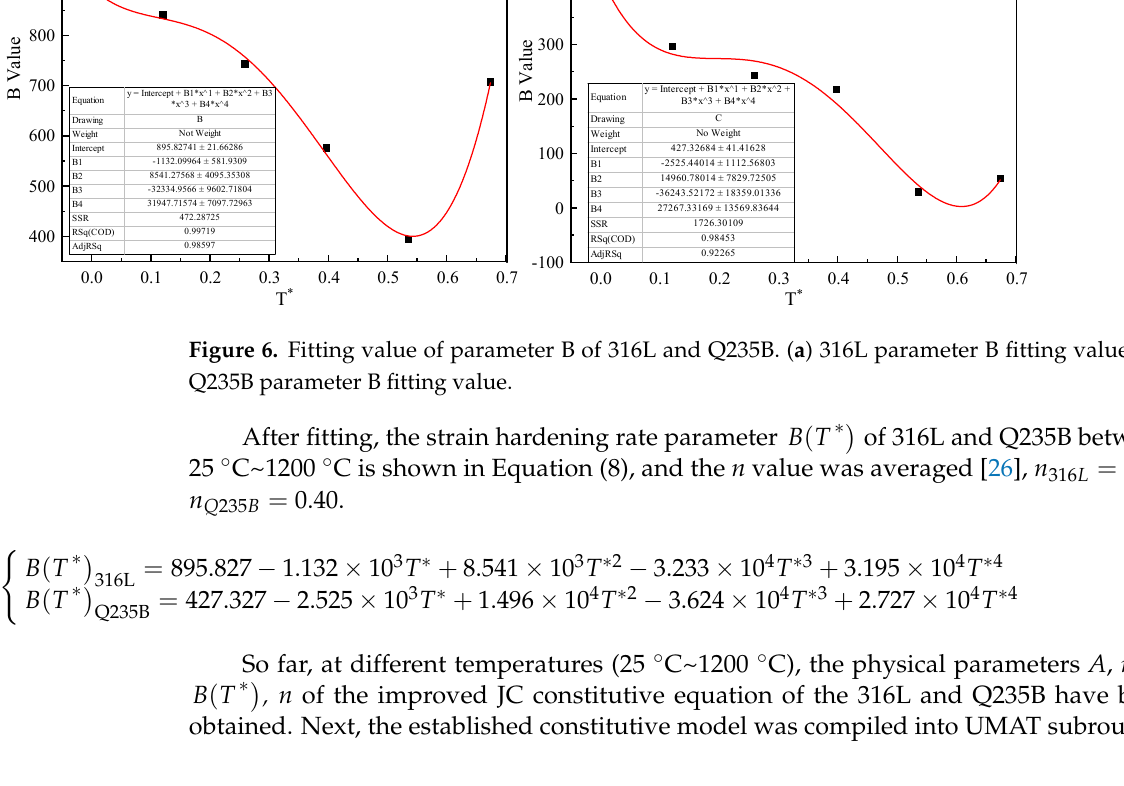
temperature. ( b ) Change of n parameter with